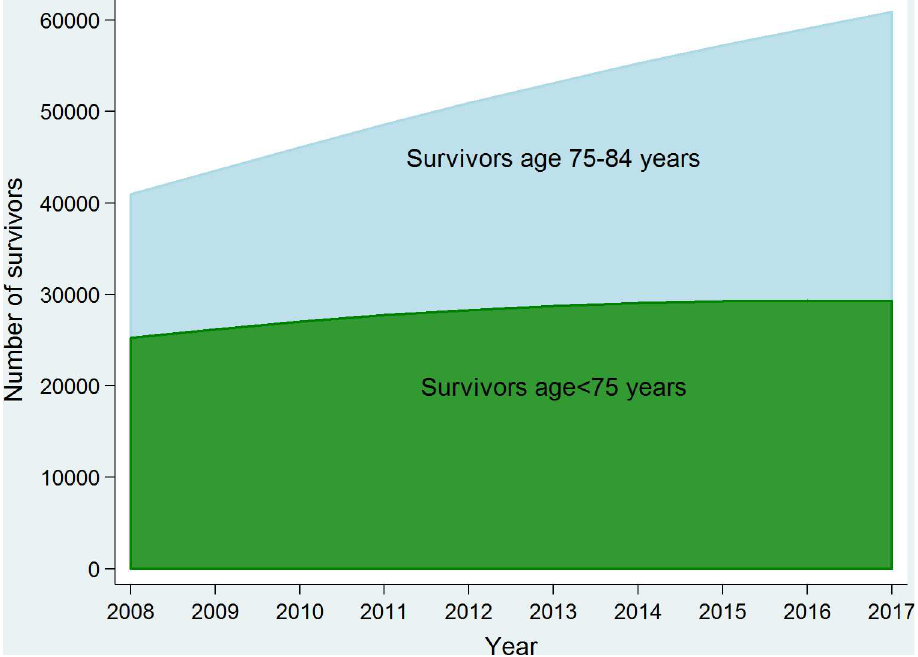
Fig 2. Trends in projected prevalenceof prostate cancer in NSW, Australia